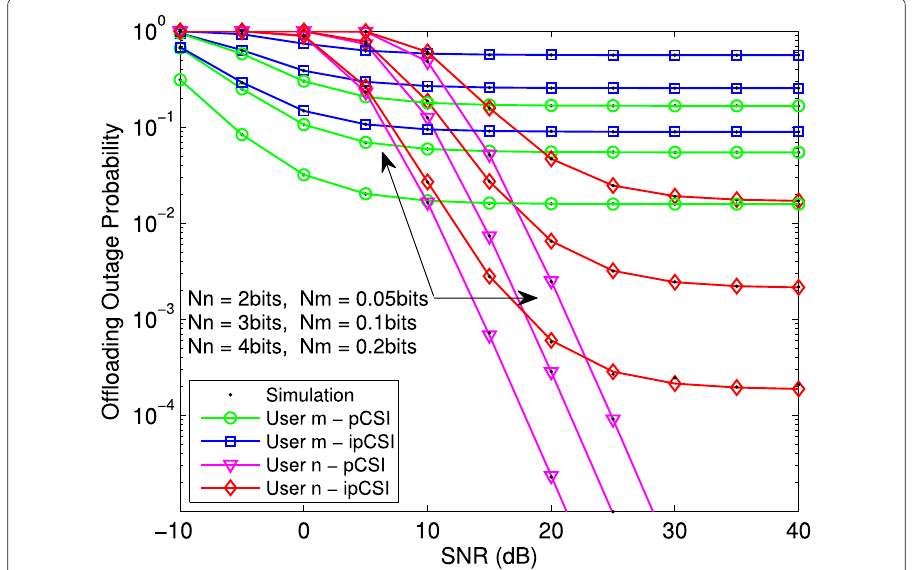
Fig. 7 Offloading outage probability versus SNR with various values of